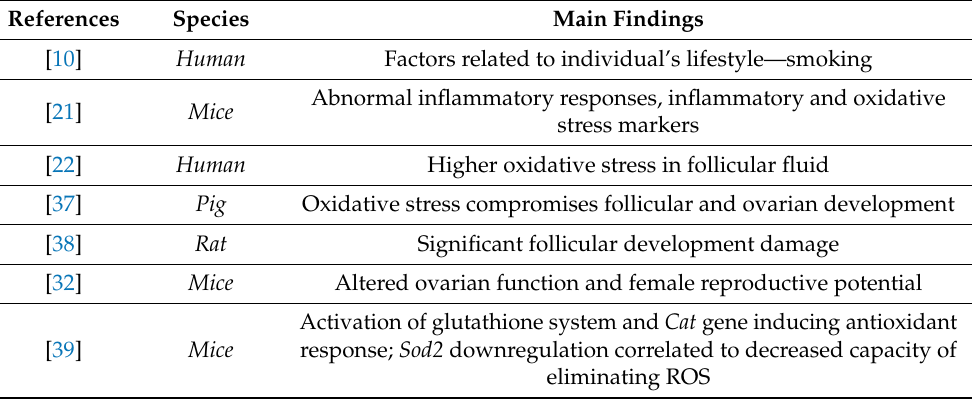
Table 3. Summary table of the main findings related to the impact of high-fat diet on ROS production and oxidative stress pathways in mammal